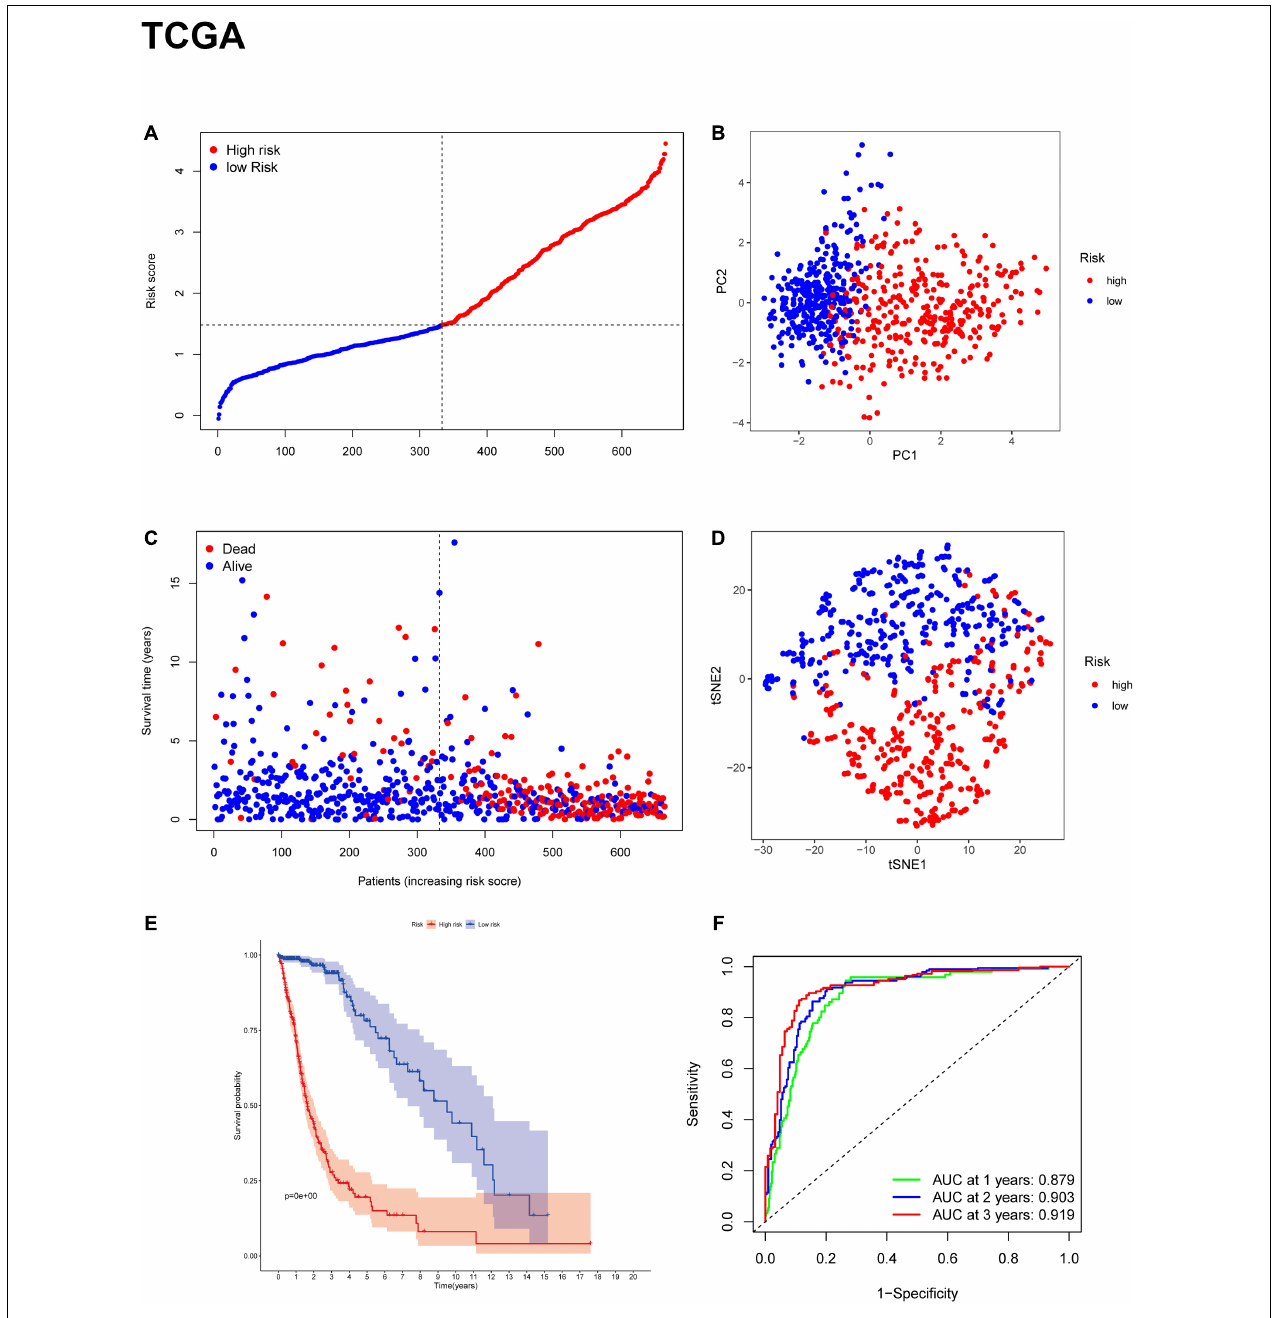
FIGURE 3 | Construction of the gene signature in the TCGA cohort. (A,C) Distribution and median value of risk scores in the TCGA cohort. (B) PCA plot of the TCGA cohort. (D) t-SNE analysis of the TCGA cohort. (E) Kaplan-Meier survival curve for the OS of patients in the high-risk group (red line) and low-risk group (blue line) in the TCGA cohort. (F) AUC of time-dependent ROC curve analysis for evaluating the prognostic performance of the risk score for OS in the TCGA